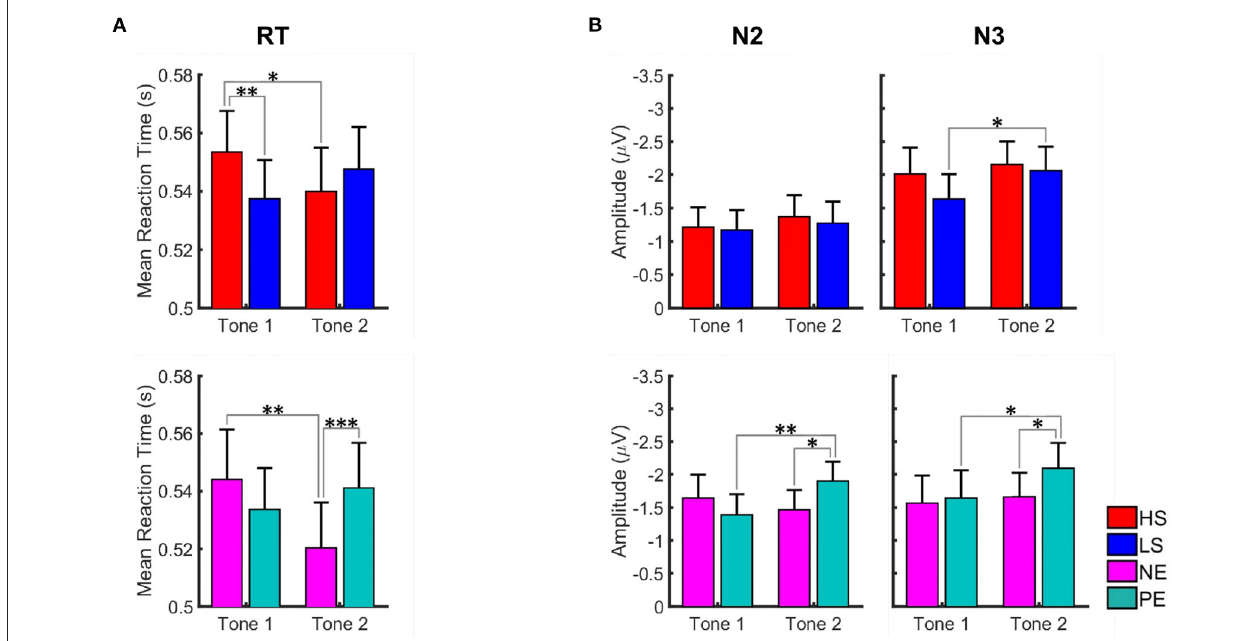
FIGURE 5 | Graph illustrating the effect of salient and valent visual stimuli on reaction time (A) and amplitudes of N2 and N3 ERP components (B) in the AMST for placebo condition. Data for high salient (HS) condition are shown in red, low salient (LS) in blue, negative valence (NE) in magenta, and positive valence (PE) in turquoise. Data are given as mean and standard error. Stars correspond to the significance levels (*** p < 0.001, ** p < 0.01, and * p < 0.05) after Bonferroni correction. We observed longer reaction times for tones presented during high salience pictures in the first tone position and shorter reaction times for tones presented during negative valence pictures in the second tone position. N2 and N3 amplitudes were greater for the tones presented during positive valence pictures in the second tone position.